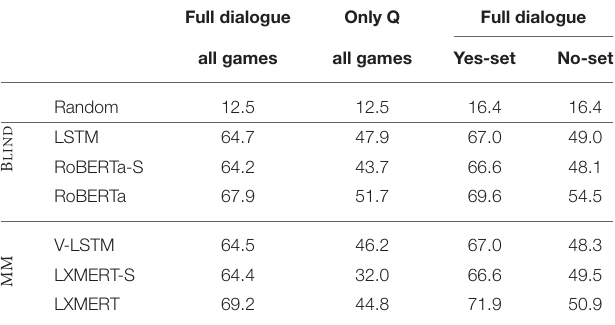
TABLE 2 | Full test set: Task Accuracy obtained by models when receiving: a) only the questions (Only Q); b) the full dialogue in the Yes-set vs. No-set, viz. games ending with a Yes-turn vs. a